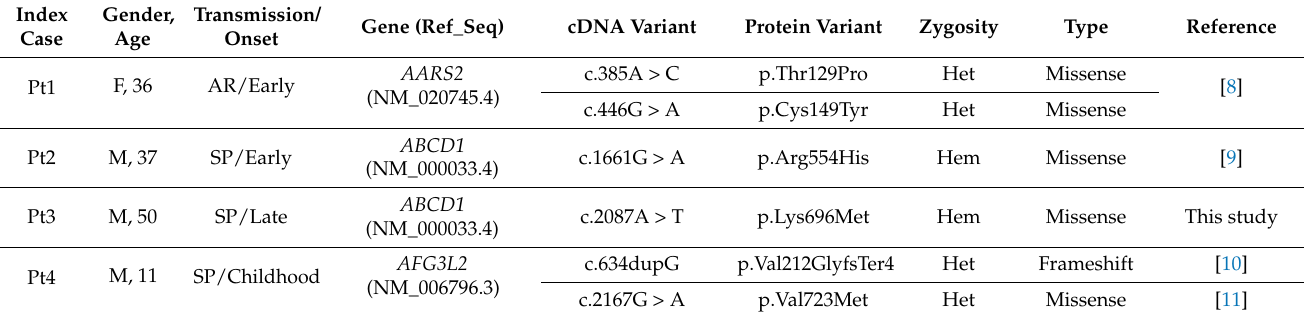
Table 1. Summary of NGS results in positive cases harboring pathogenic and likely pathogenic